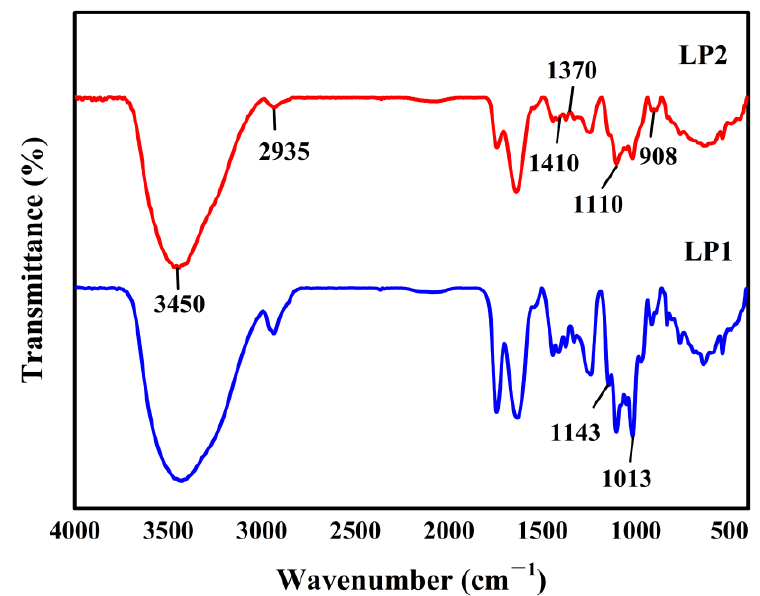
Figure 2. The FT-IR spectra of LP1 and LP2 were acquired over a frequency range of 4000 – 400 cm − 1 .